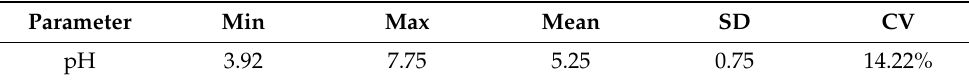
Table 2. Descriptive statistics of soil pH.